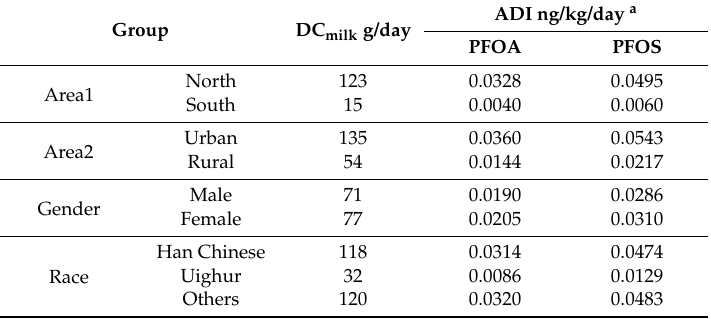
Table 4. Average daily intake of PFOS and PFOA for various groups in terms of area, gender, and race.